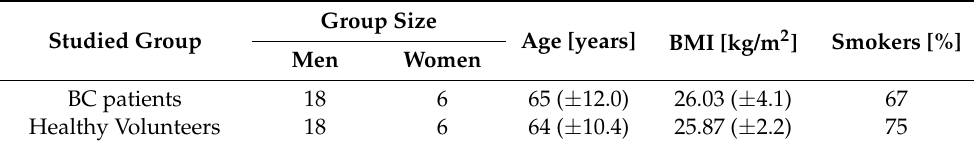
Table 1. Demographic characteristics of the studied